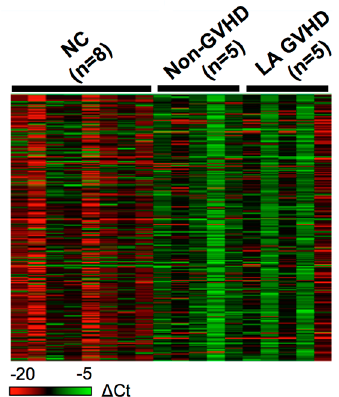
Figure 2. miRNA expression profiling using TaqMan miRNA Array (Thermo Fisher Science, Waltham, MA, USA). Exosome fraction taken from plasma samples of 10 patients who underwent allogeneic HSCT (5 late-onset acute GVHD and 5 non-GVHD), with 8 normal controls being included. A differential expression pattern was found between late-onset acute GVHD patients and non-GVHD patients. Using SDS (version 2.4) and DataAssist software (version 3.01, Thermo Fisher, version, Waltham, MA, USA), we calculated the expression of miRNAs based on their Ct value normalized by the Ct value of ath-miR-159. Data were analyzed with GeneSpring software.